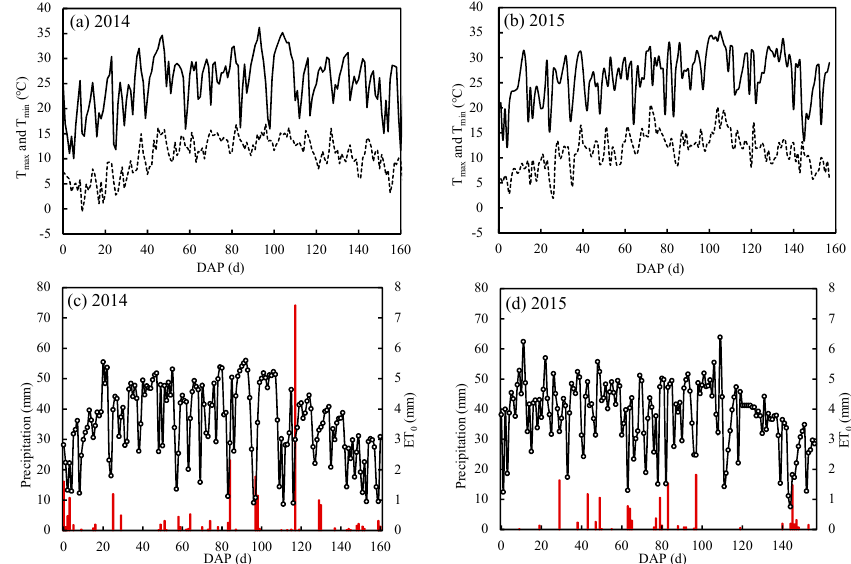
Figure 1. Variations in daily meteorological data against days after planting (DAP) of seed maize in 2014 and 2015, including maximum ( T max , —) and minimum ( T min , – – – –) air temperature, precipitation ( ▐ ) ), and reference evapotranspiration ( ET 0 , —- ◦